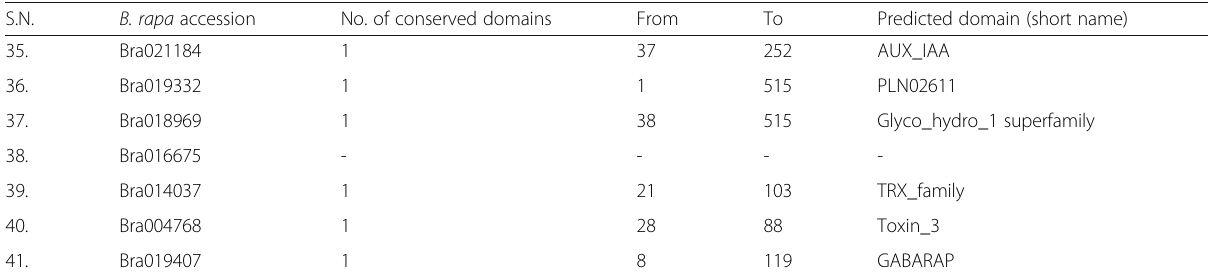
Table 2 Predicted conserved domains in identified upregulated Brassica rapa sequences with their positions under contrast WTC (Continued)